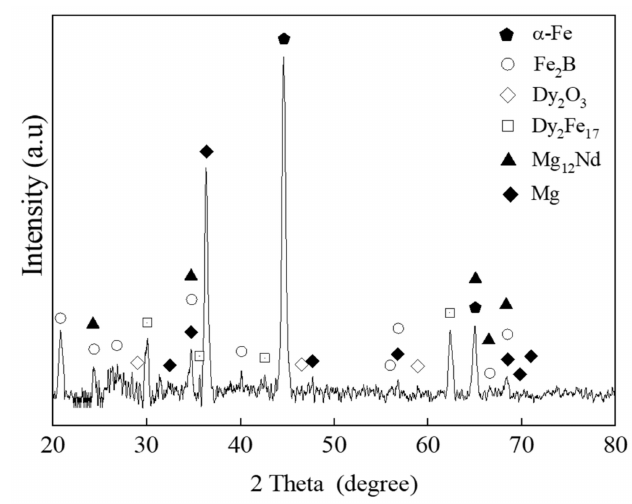
Figure 4. XRD pattern of the matrix at a reaction time at 3